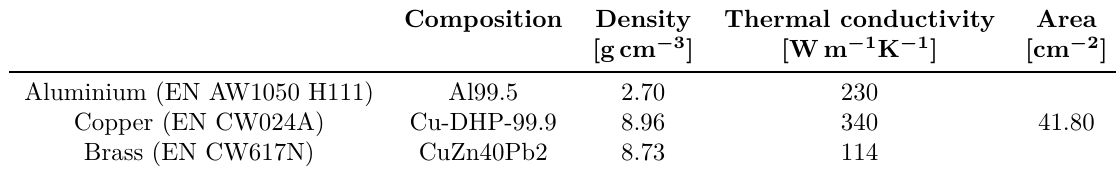
Table 2. The selected parameters of the metal